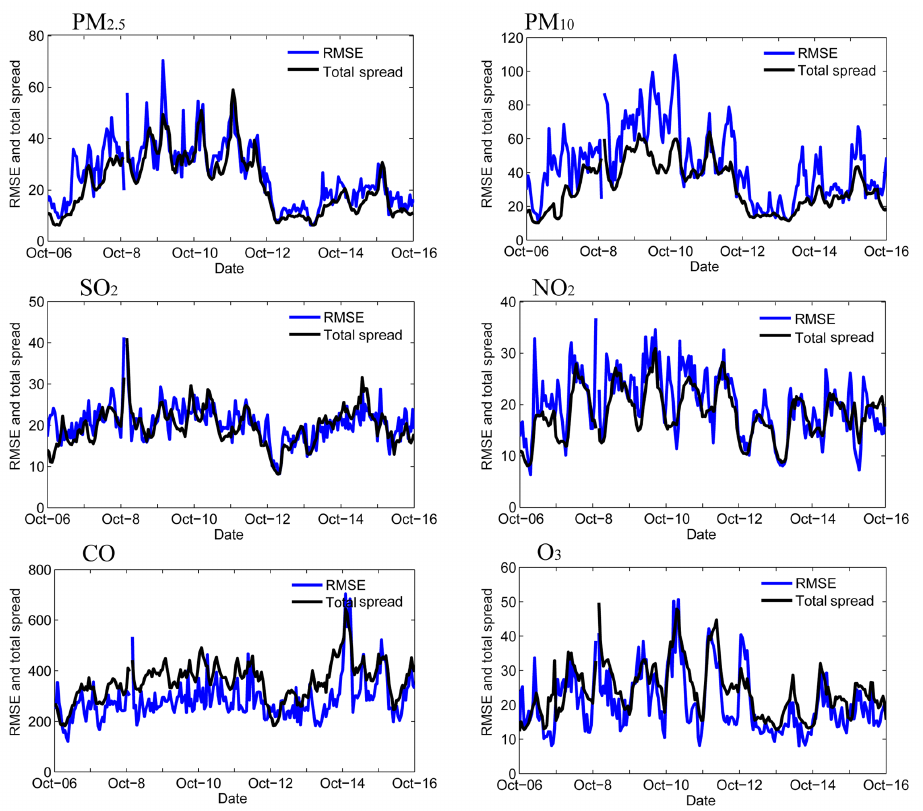
Figure 2. Time series of prior ensemble mean RMSE (blue line) and total spread (black line) for PM 2 . 5 , PM 10 , SO 2 , NO 2 , CO, and O 3 concentrations aggregated over all observations over the Beijing–Tianjin–Hebei region. Units for all these variables: µgm − 3